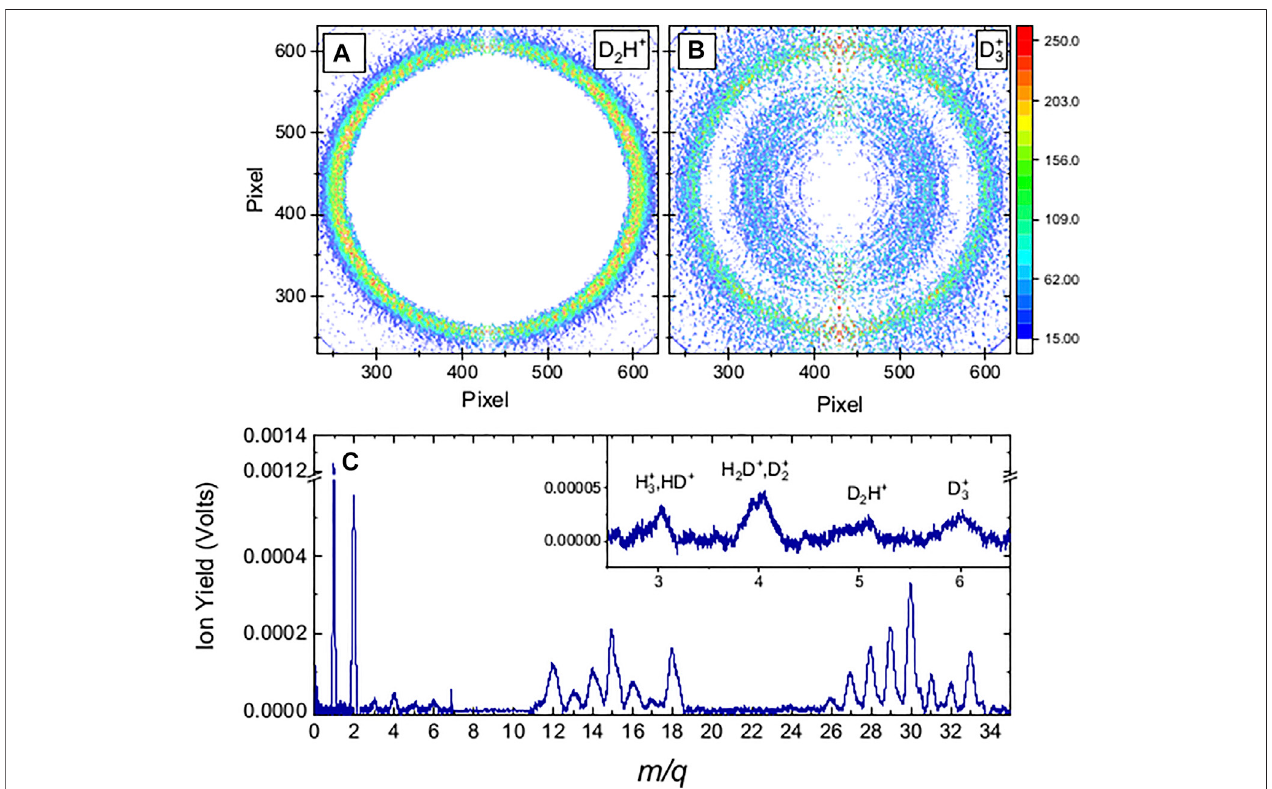
FIGURE 1 | Molecular fragmentation data obtained with 35 fs FWHM, 1.3 × 10 14 W/cm 2 pulses centered at 785 nm, the conditions used in the closed-loop experiment. (A) Inverse Abel transformed VMI of D 2 H + ions. (B) Inverse Abel transformed VMI of m / q (cid:2) 6, which contains D + 3 and C 2+ ions. At this intensity, the two featuresareseparated, withtheC 2+ ionsinsidetheD + 3 ring.ThelaserpolarizationisverticalfortheVMIdata. (C) Currentmodetime-of- fl ight(shownasafunctionof m / q ) showingthattheintegratedyieldofthe m / q (cid:2) 5and m / q (cid:2) 6peaksaresimilar.Whenonlytheyieldfromthehighermomentumfeatureinthe m / q (cid:2) 6isconsidered, the ratio of D 2 H + to D + 3 is approximately 7:1, in agreement with the results of Kanya et al. [32]. The laser polarization is perpendicular to the time-of- fl ight axis in (C) .